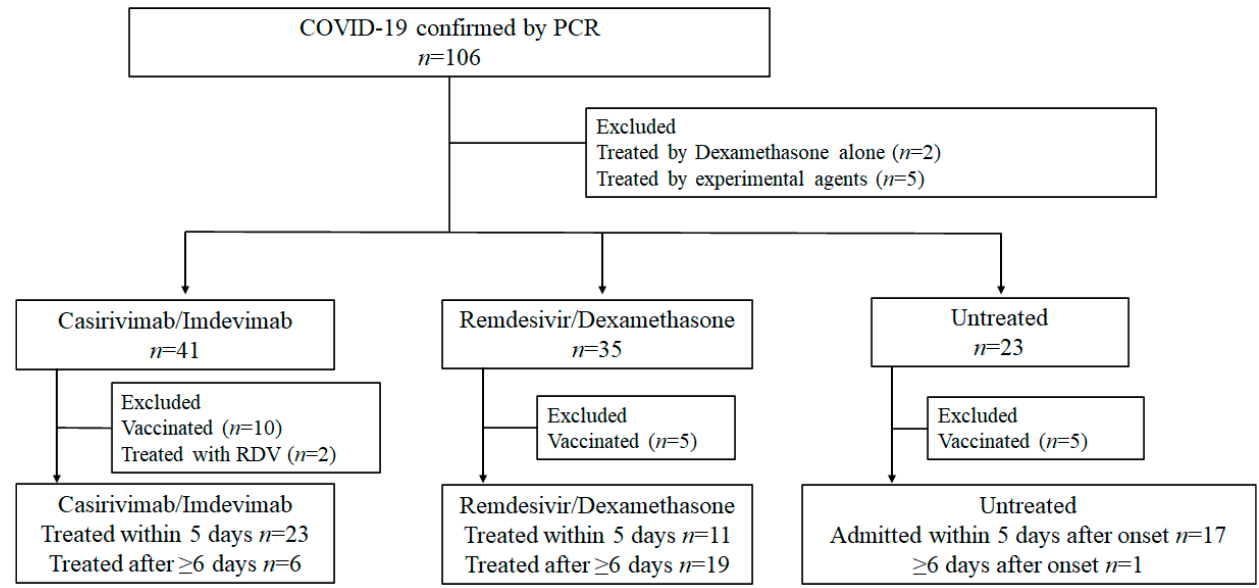
Figure 1. Flow chart illustrating distribution of this